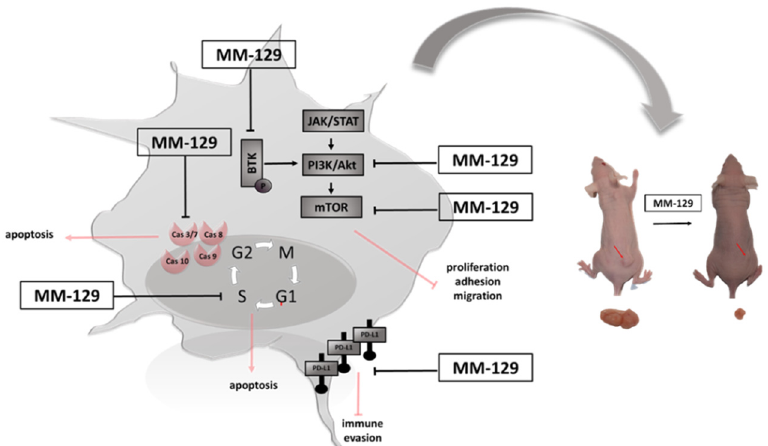
Figure 1. Schematic representation of possible anticancer mechanisms of MM-129. Abbreviations: BTK—Bruton’s tyrosine kinase; JAK—non-receptor tyrosine kinase; STAT—signal transducer and activator of transcription; mTOR—mammalian target of rapamycin; Akt—protein kinase B; PI3K—phosphoinositide 3-kinases; PDL1—Programmed death-ligand 1; MM-129—pyrazolo[4,3-e]tetrazolo[4,5-b][1,2,4]triazine sulfonamide.